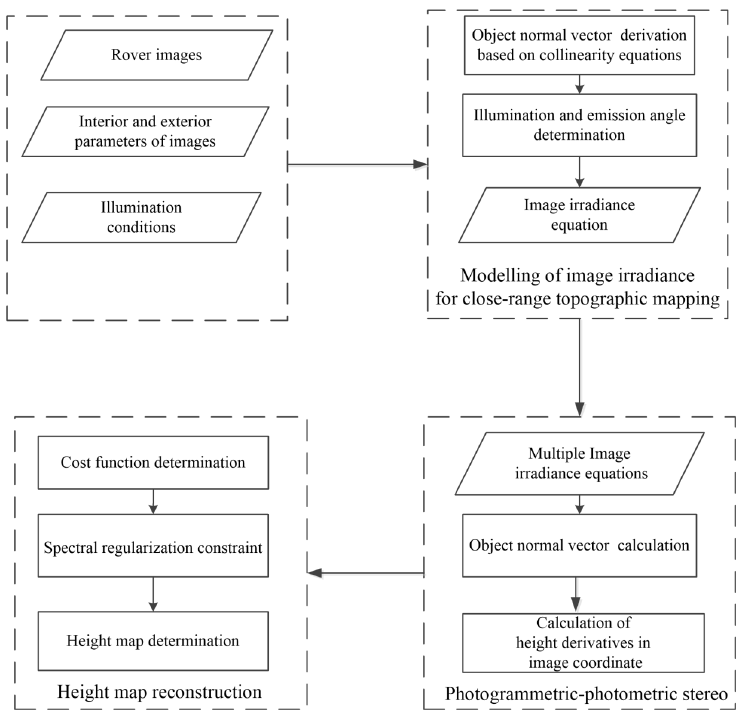
Figure 1. Framework of photogrammetric-photometric stereo (PPS)